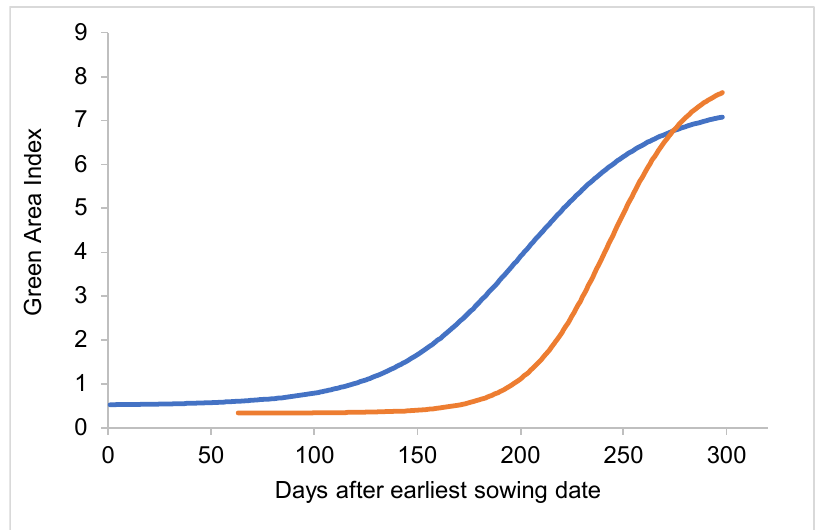
Figure 3. Example crop growth curves that can be used as model input to quantify the competitive ability of a crop canopy. We propose deriving a standard set of logistic curves for Green Area Index (GAI) and height for each country x crop combination plotted against calendar days after the earliest sowing date using parameters for a typical seed rate and cultivar. The parameters of the curves can subsequently be modified to account for changes in sowing date, seed rate, sowing arrangement and cultivar competitiveness either using empirical data or simulation models. This is illustrated using the example of winter wheat GAI in the UK sown early at a high seed rate and using a cultivar with more prostrate leaves (blue line) compared to a late sown crop with a low seed rate and using a cultivar with more erect leaves (orange line). Curves have been fitted to predicted data from a simulation model [31].